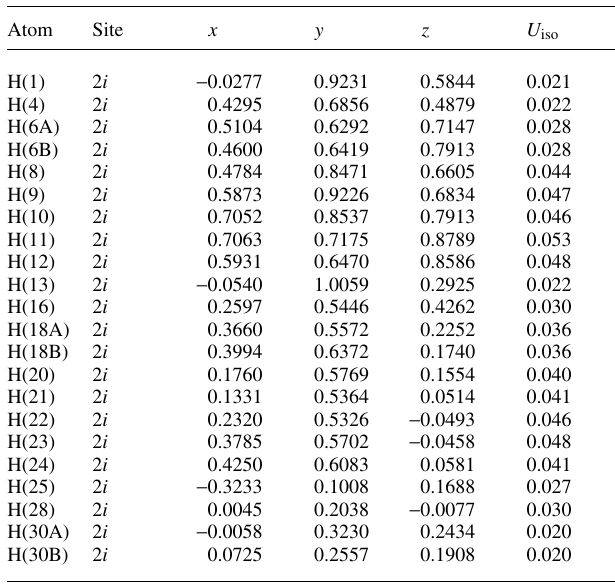
Table 2. Atomic coordinates and displacement parameters (in Å 2 )